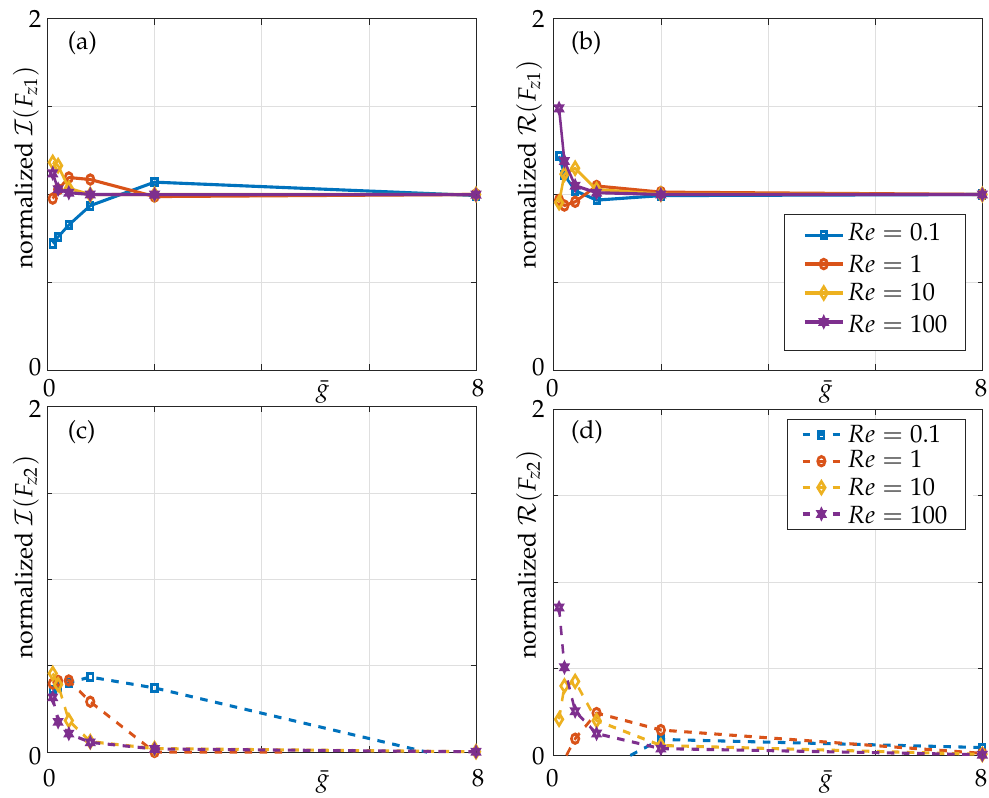
Figure 7. Hydrodynamic load of 2 beams for different gap sizes ¯ g subject to the 1–0 actuation mode; ( a , c ) imaginary parts of forces, ( b , d ) real parts of forces; ( a , b ) actuated beam 1, ( c , d ) passive beam